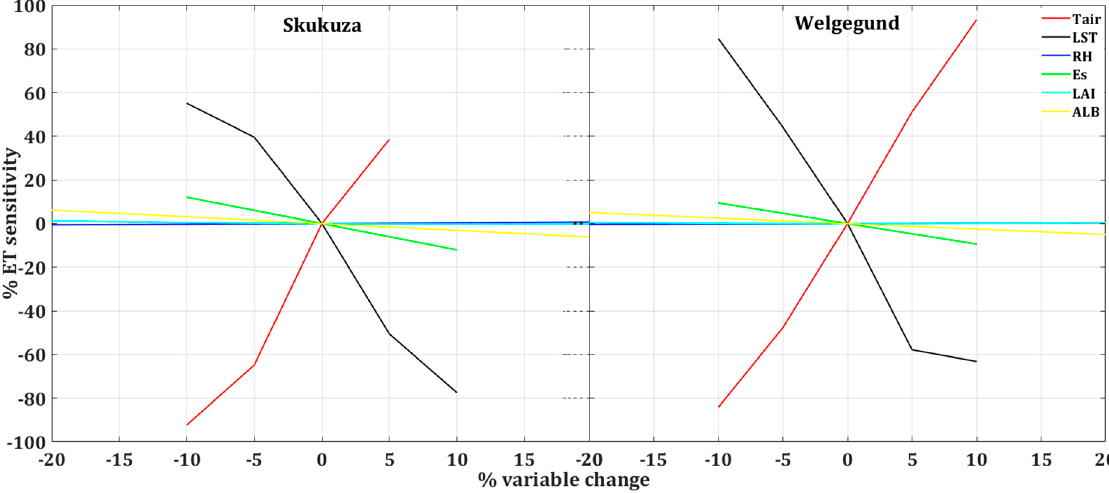
Figure 4. Sensitivity of the PM-Mu ET model to input variables.